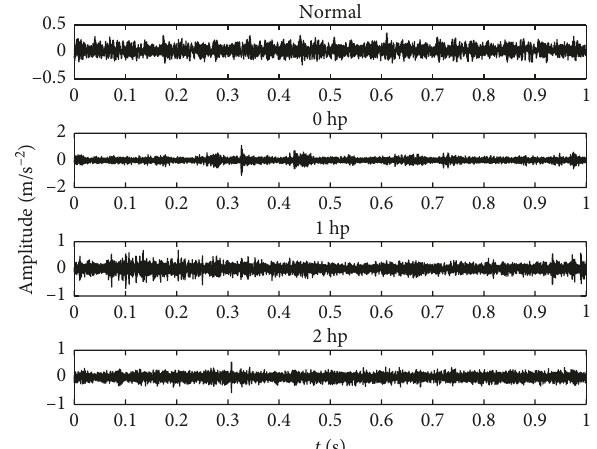
Figure 8: Rolling body minor fault signals under three different